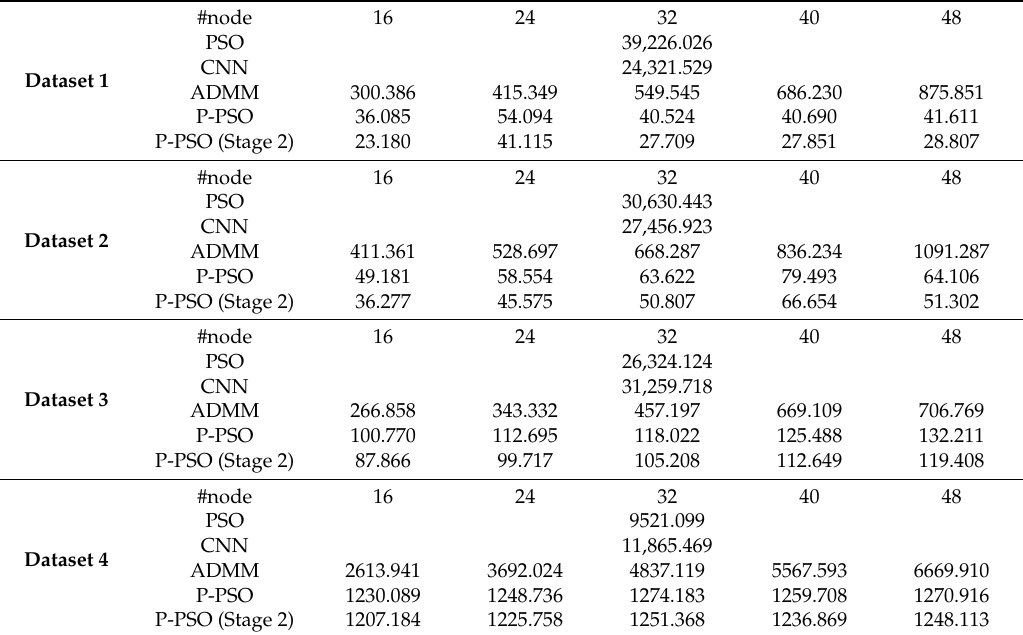
Table 4. Comparative results of training